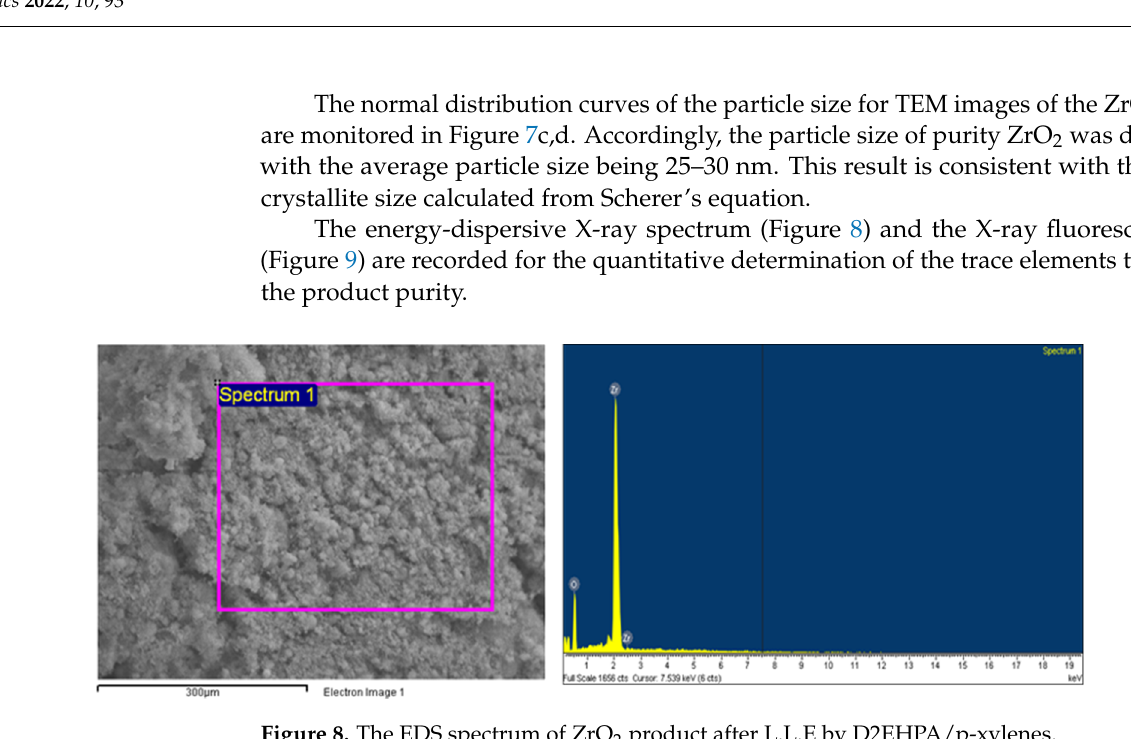
Figure 8. The EDS spectrum of ZrO 2 product after L.L.E by D2EHPA/p-xylenes.